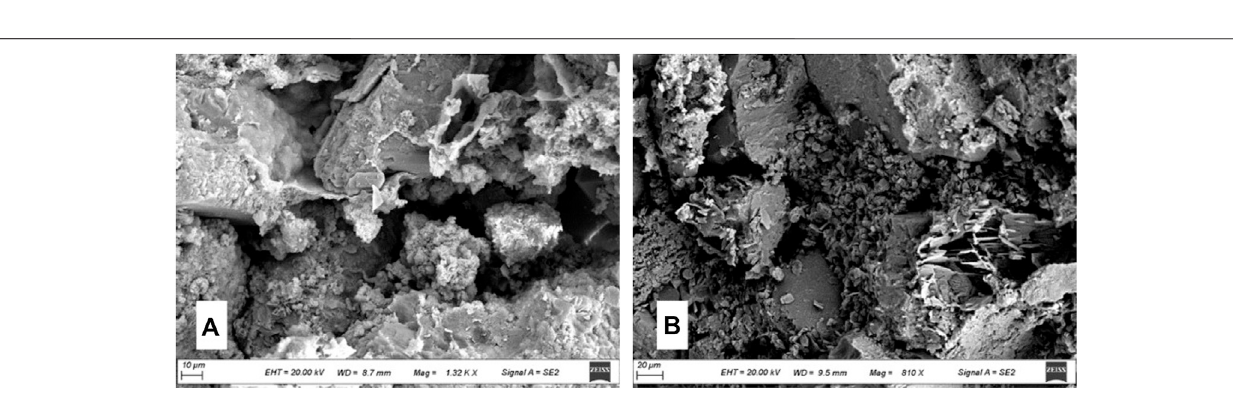
FIGURE 5 | Intergranular pore morphology after ASP fl ooding ( A : primary intergranular pore throat, B : local pore throat).